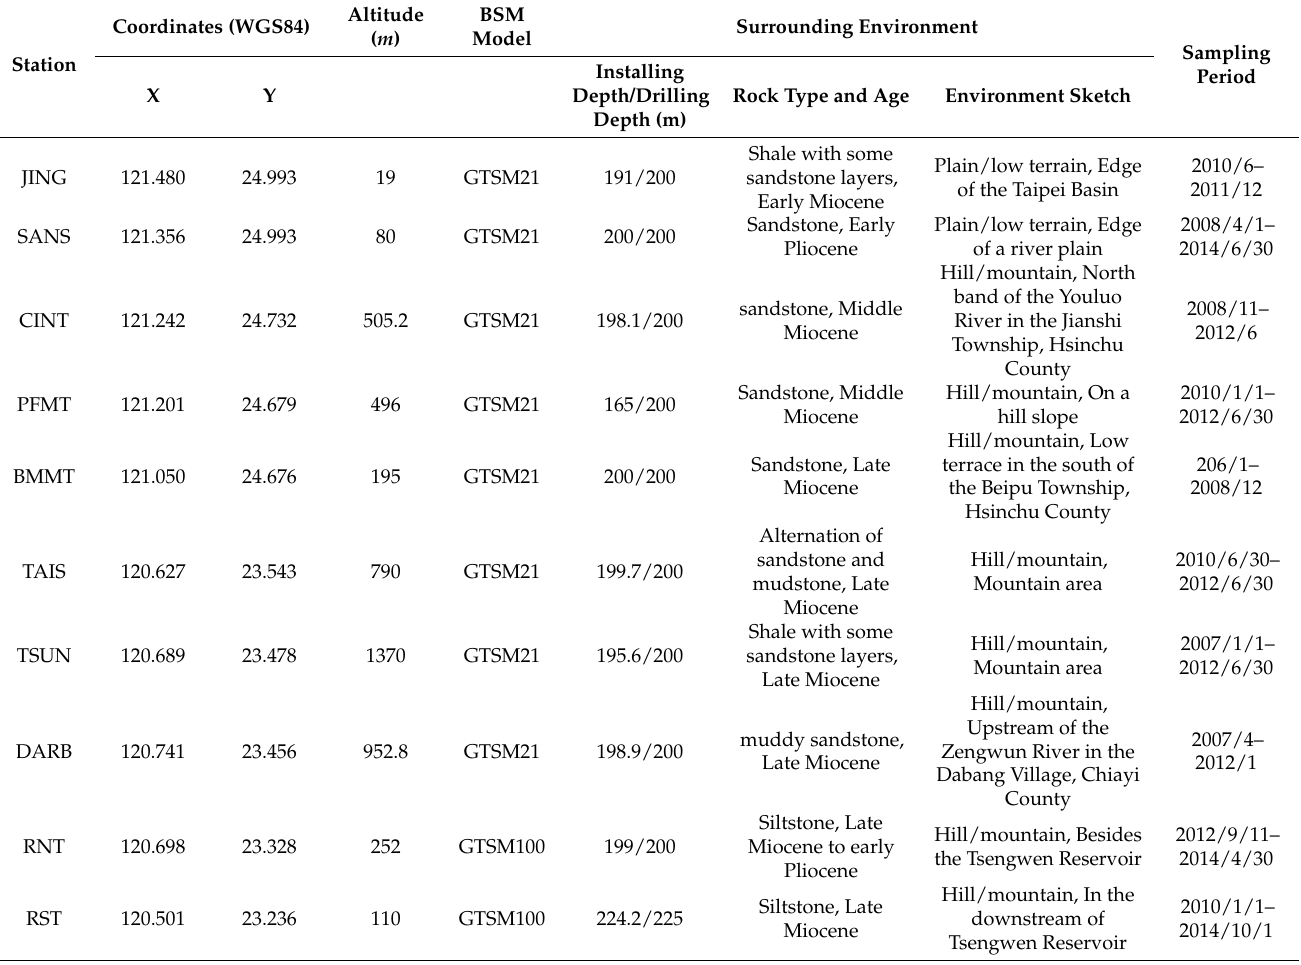
Table 1. Basic information of the borehole strainmeter